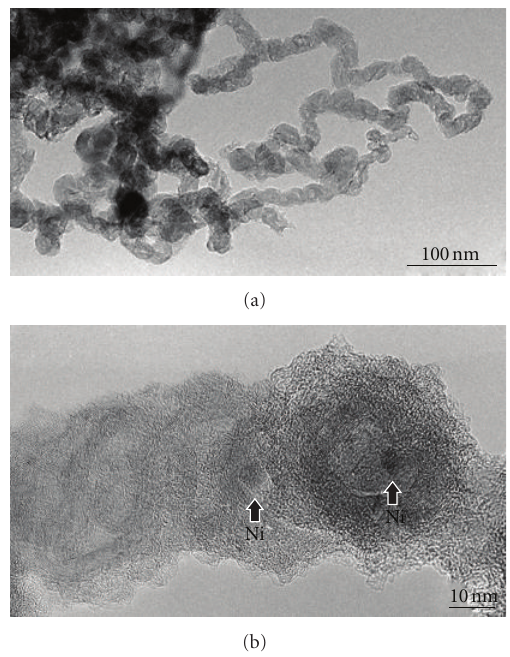
Figure 5: (a) Bright-field images of Ni-encapsulated carbon nanocapsules prepared by heating Ni-doped C 60 nanowhiskers (specimen B) at 1173 K. The nanocapsules form chain structures. (b) High-resolution image of the chain of Ni-encapsulated carbon